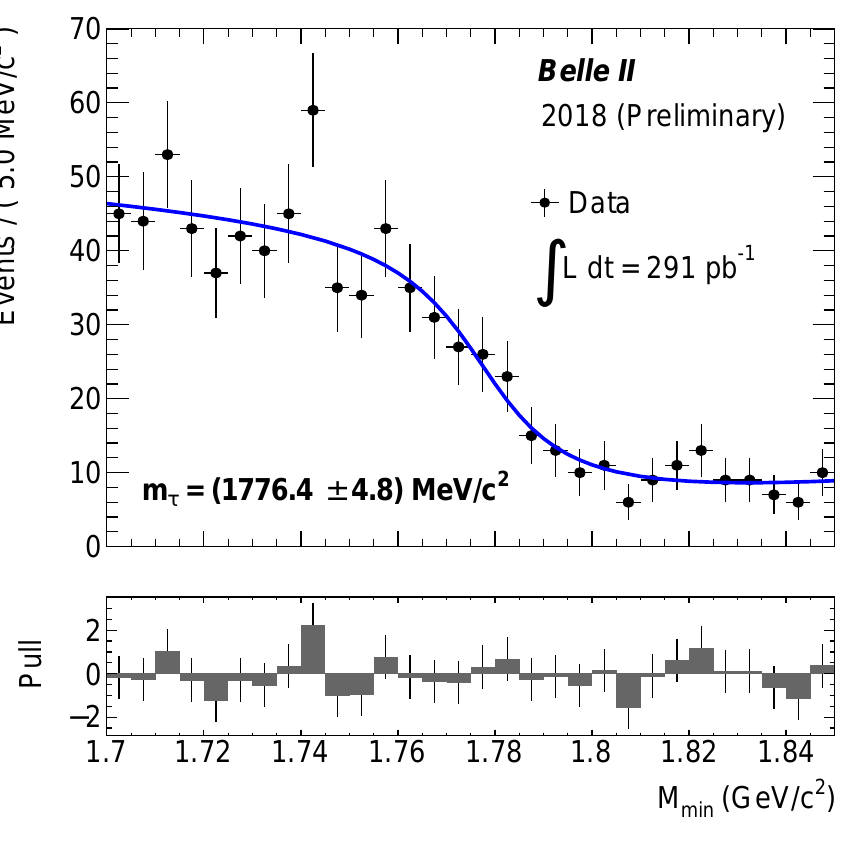
+ 2 ( E − E )( E − P ) of = (cid:113) M 2 beam min 3 π 3 π 3 π 3 π + b ) · arctan [( m ∗ − M ) / c ] + P ( M ) , in which min min min 1